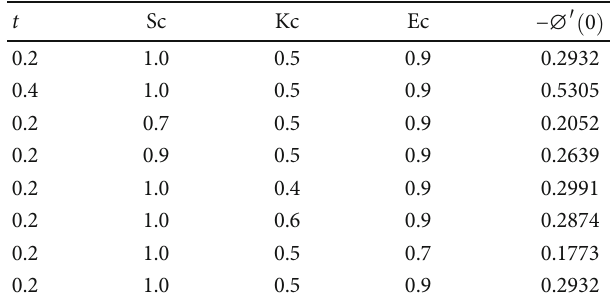
Table 2: Distinct values of t , Sc, Kc, and Ec for Sherwood number ( −∅ ′ ð 0 Þ ) at the